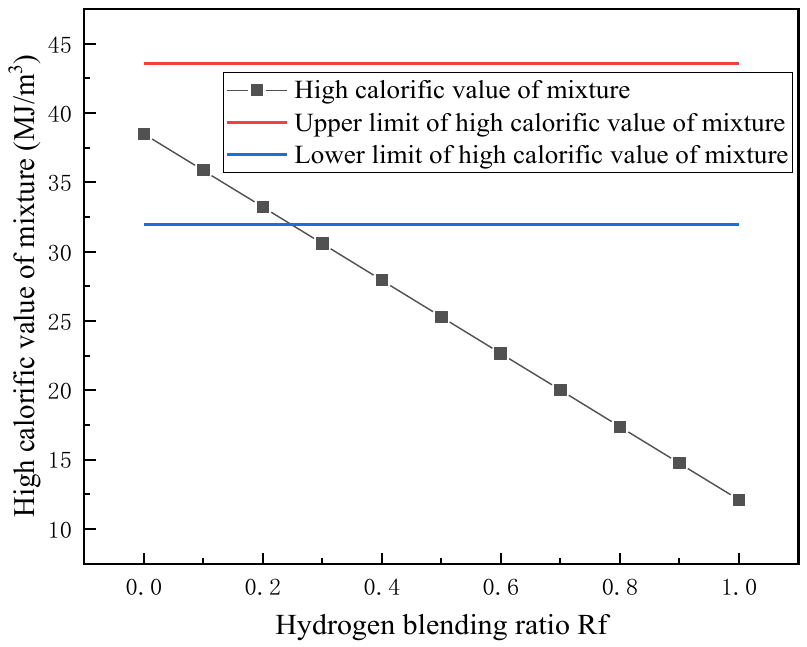
Figure 6. Calculation of high calorific value of mixture.